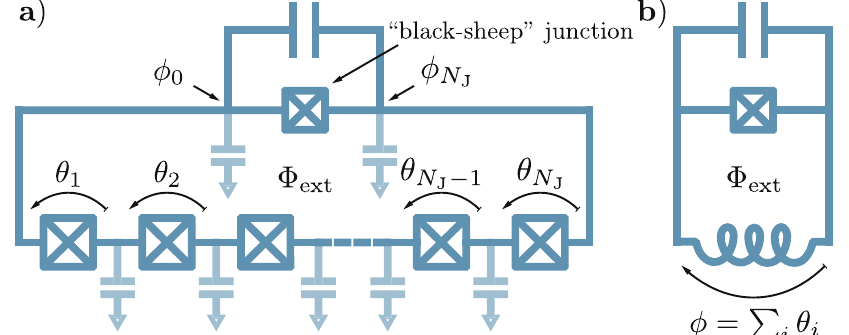
Fig. 1 Circuit model of the fl uxonium qubit. a Detailed circuit scheme including a “ black-sheep ” junction (center) shunted by a capacitance (top) and a junction-array superinductance with N J junctions (bottom). Stray capacitances to ground are depicted in a lighter shade of blue. b Effective circuit in which the junction array is modeled as a linear inductance. ϕ i for i ∈ [0, N J ] denotes the superconducting phase at every circuit node, while θ i for i ∈ [1, N J ] is the phase difference at every junction of the array. The superinductance (or fl uxonium) mode is de fi ned as the phase difference across the black-sheep junction: ϕ ¼ ϕ 0 (cid:2) ϕ N